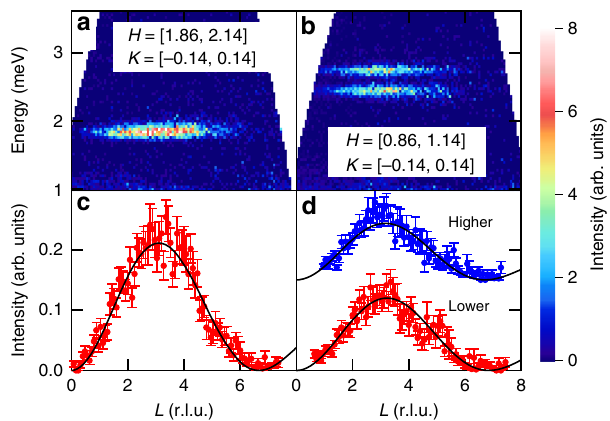
Fig. 3 Excitation spectra along L directions. a , b Color contour maps of scattering intensities along the L ( c * ) direction. The common color scale is used. Integrated H and K ranges are shown in the fi gures. c , d Integrated intensity plotted against L together with a fi t using the dimer structure factor represented by a solid black curve. Red circles in Fig. 3c are obtained by integrating the intensities shown in Fig. 3a between 1.66 and 2.06meV. Red and blue circles in Fig. 3d correspond to integrated intensities between 2.22 and 2.58 meV and between 2.62 and 2.98 meV from Fig. 3b, respectively. The intensity of the higher branch is shifted upward for clarity. Error bars represent standard deviation. Source data are provided as Fig. 2a as functions of energy transfer E . At small H and K , two peaks along the H and K directions overlap. At H and K of 0.68 r. l.u., they start to move apart and form two well-separated peaks. The right peak at 2.50 meV decreases and disappears above 0.80 r.